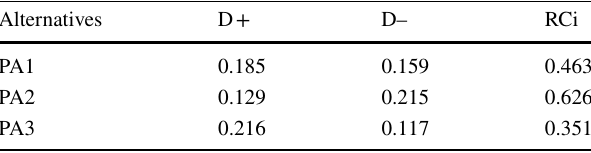
Table 16 The values of D + , D–, RCi with Q-ROFSs Alternatives